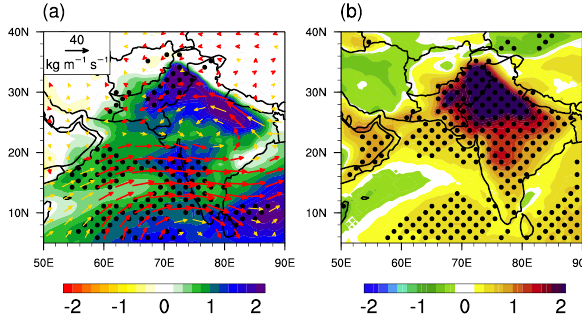
Figure 17. Spatial patterns of WRF-Chem ensemble mean differ- ences in (a) precipitable water (shading; unit: mm) and water vapor flux (arrows; units: kgm − 1 s − 1 ) both integrated within the entire atmospheric column and (b) moist static energy (units: kJkg − 1 ) in the three lowest model layers. Black dots represent the differences in precipitable water and moist static energy that have a 95% con- fidence level based on a one-sided Student’s t test. The red arrows represent wind differences that have a 95% confidence level, and the gold arrows represent other wind differences (no